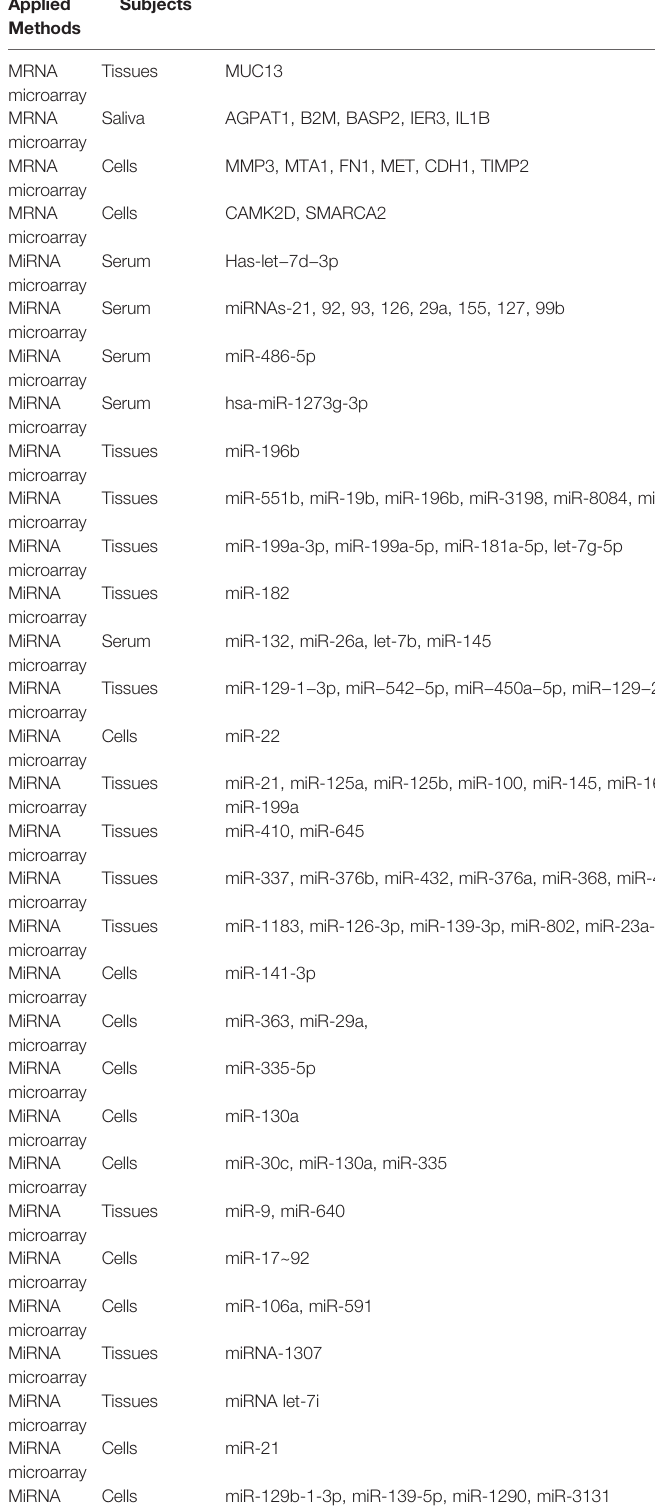
TABLE 2 | The application of transcriptomics for exploring the candidate biomarkers for ovarian cancer . Applied